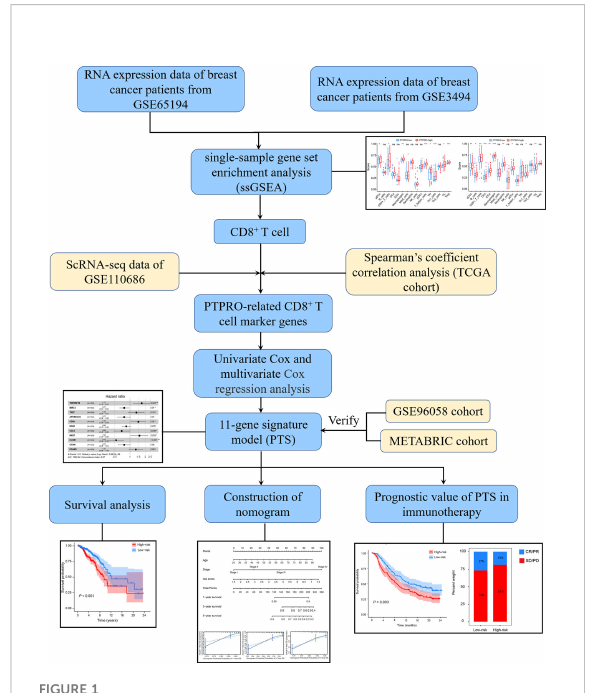
FIGURE 1 The fl owchart of signature construction and veri fi